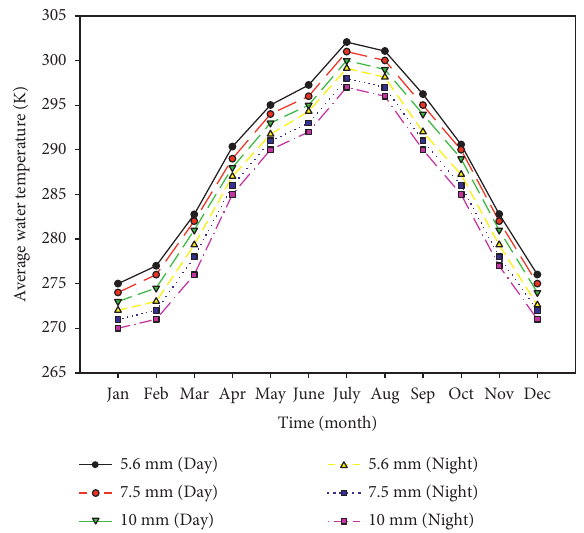
Figure 8: Effect of water depth on average water temperature for reactor inclined at 1 ° , Re � 9000, and aspect ratio �